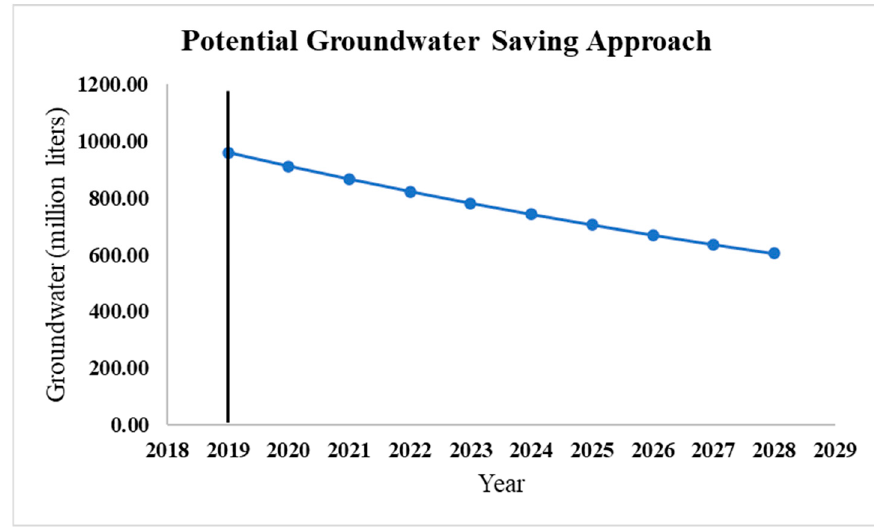
10 Figure 8. COD & BOD amount in effluent discharged wastewater. 4. Discussion 4.1. Yearly Basis KPI% Reduction Approach and Potential Saving Figure 9 demonstrates a potential groundwater saving (yearly 5% reduction) ap-